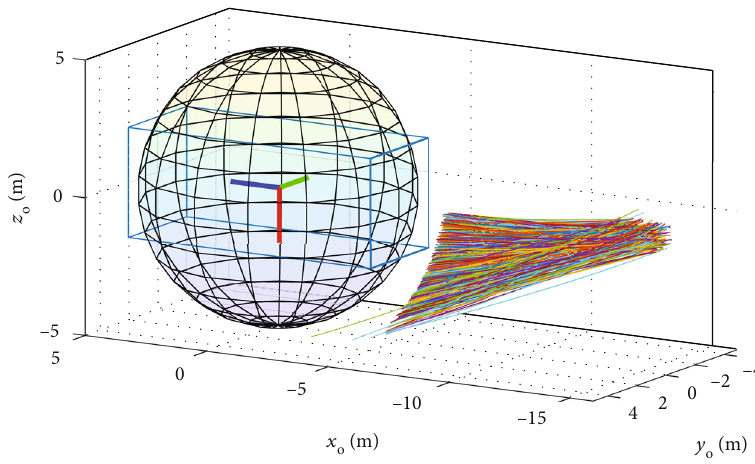
min . The blue cuboid on the left is